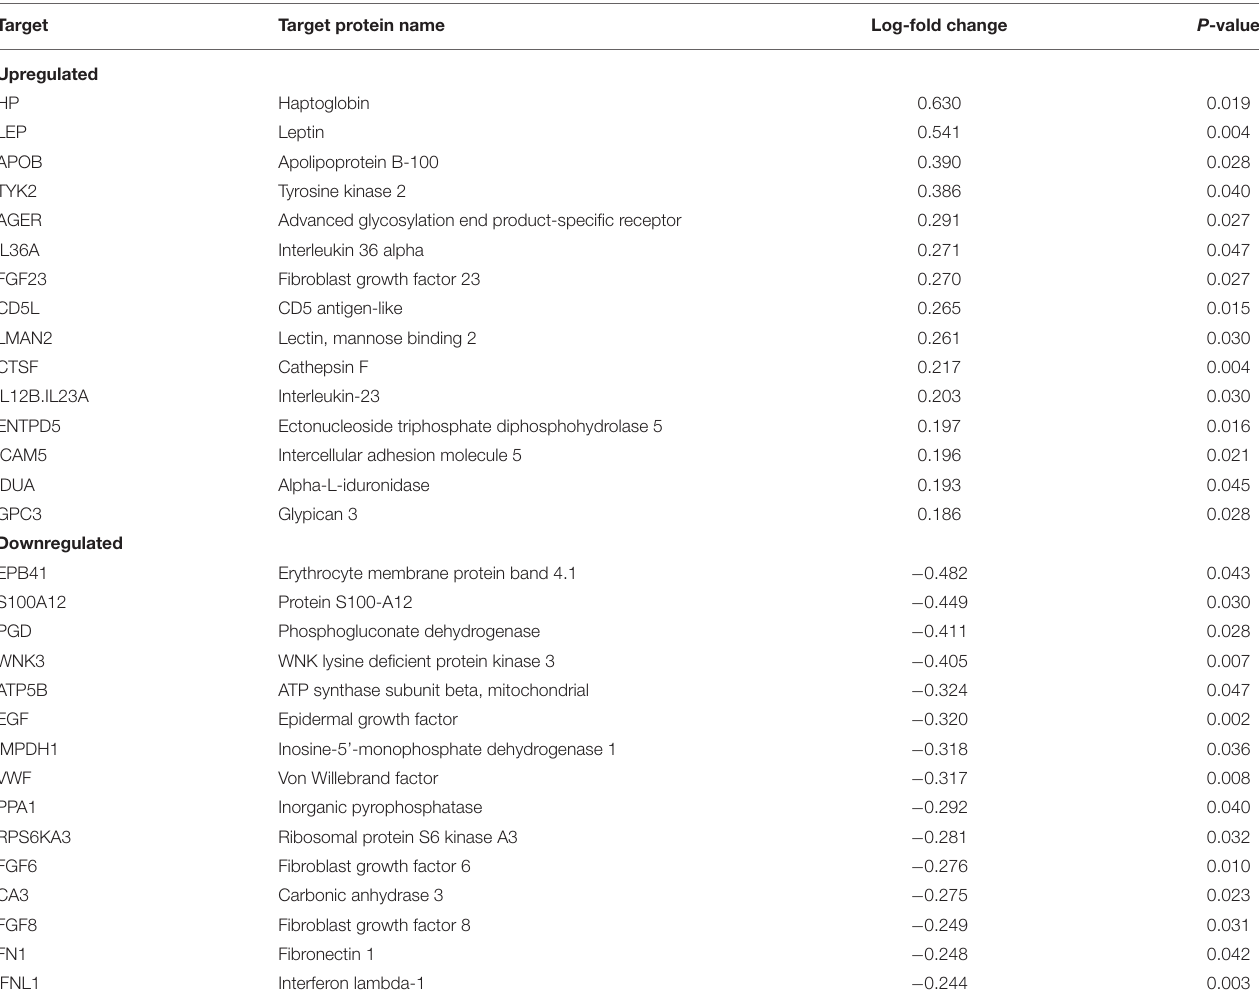
TABLE 2 | Protein expression differences between recovery ≥ 14-days and <